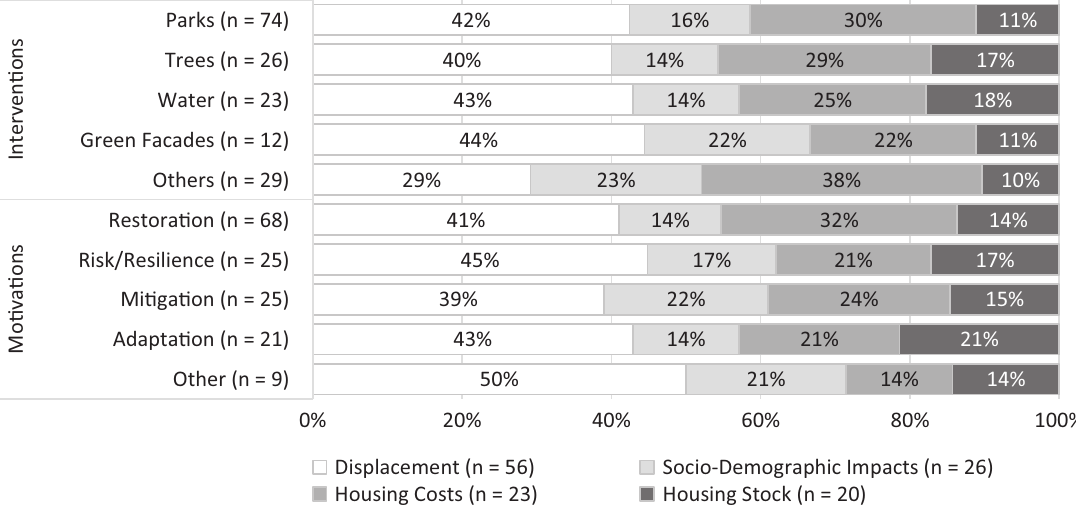
Figure 5. Motivations, types, and effects of NbS